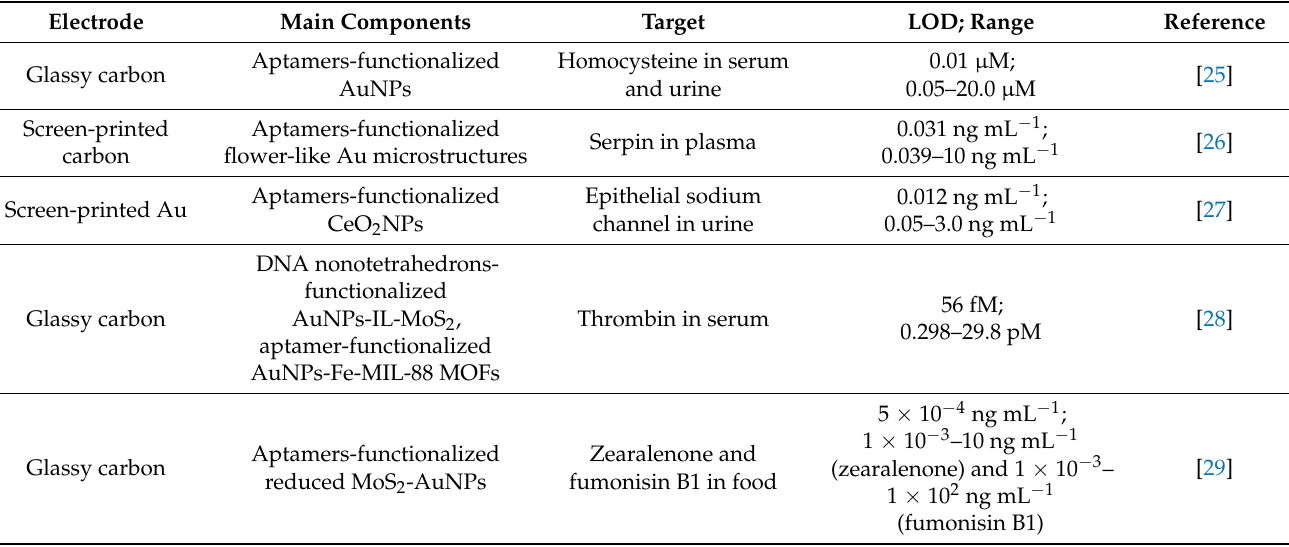
Figure 5. Electrochemical aptasensor for sialic acid in serum. Carbon electrode coated with Au nanodendrites and aptamers are used to sense sialic acid molecules whose presence is amplified by taking advantage of 4-mercaptophenylboric acid-thionine-functionalized AuNPs. Image adapted from [54] with permission of John Wiley and Sons, 2020. Table 1 provides a list of the current electrochemical aptasensors reported in this review and their main features. Table 1. Electrochemical aptasensors cited in this